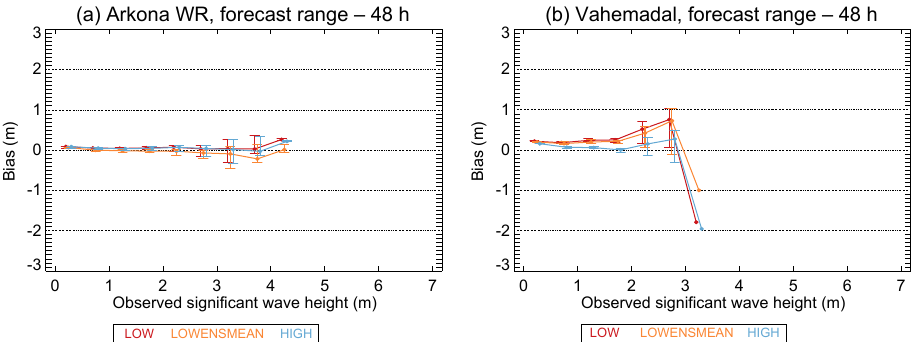
Figure 9. Bias as function of SWH for the Arkona WR (a) and Vahemadal sites (b) for the LOW, LOWENSMEAN and HIGH forecasts with a forecast range of 48h. Error bars show the 5% and 95% confidence bands calculated by